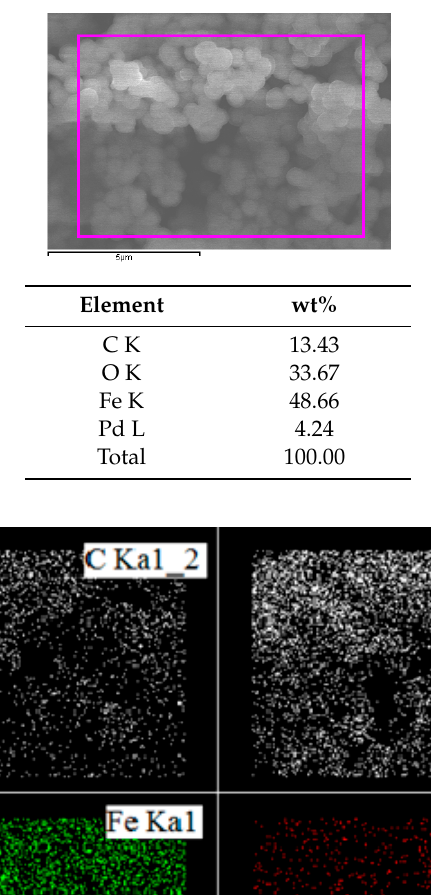
Table 1. EDS spectra of Fe 3 O 4 @PDA@Pd.